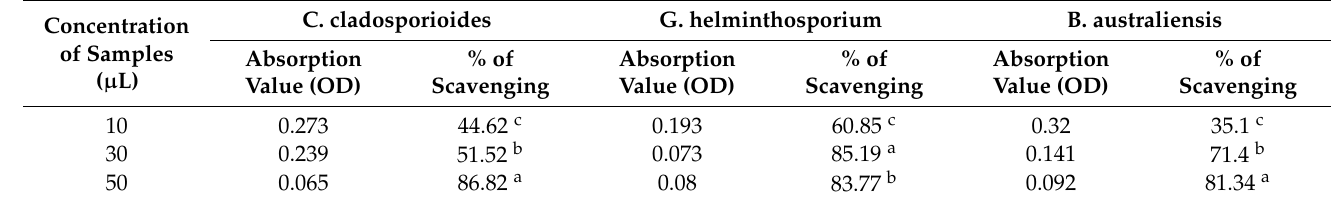
Table 9. Nitric oxide antioxidant scavenging activity of the intracellular methanolic extract of Cladosporium cladosporioides, Graminicolous helminthosporium , and Bipolaris australiensis . Data are represented as means ± SD of three replicates. Numbers within a column followed by the same letters are not significantly different according to Duncan’s multiple range test at p ≤ 0.05.